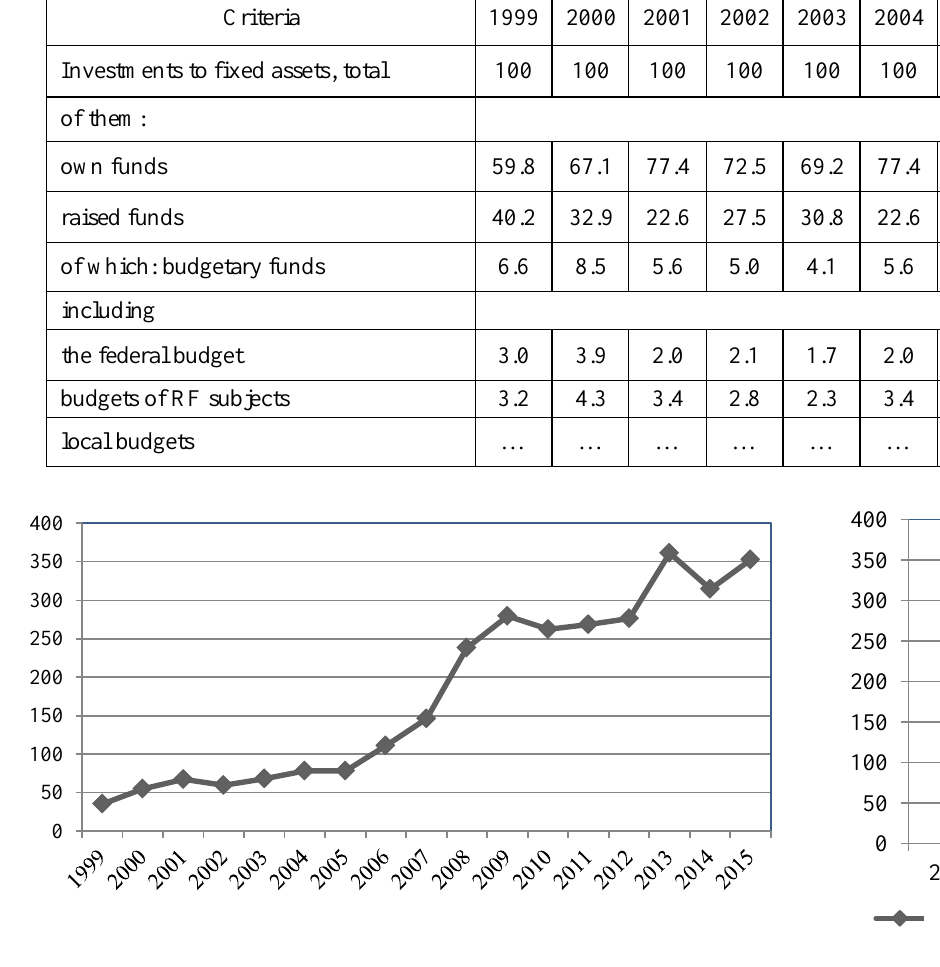
Table 4. The structure of investments to the capital stock for agricultural development as per sources of funding for 1999 – 2015, % [13] Criteria